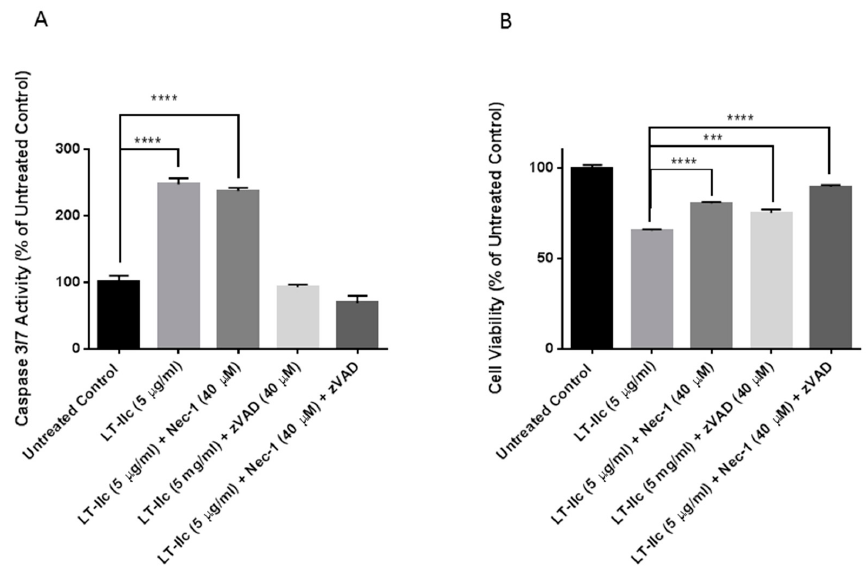
Figure 9. LT-IIc induces cell death through combined induction of apoptosis and necroptosis. MDA-MB-231 cells were treated with LT-IIc (5 µg/mL) in the presence or absence of Z-VAD-FMK (40 µM) and/or necrostatin-1 (40 µM) for 48 h. ( A ) Following treatment, caspase 3/7 activity was assessed using Apo-ONE ® Homogeneous Caspase-3/7 assay. ( B ) Cell viability was determined using MTT assay. Bars represent means ± SEM. Key: *** p < 0.001; **** p < 0.0001.